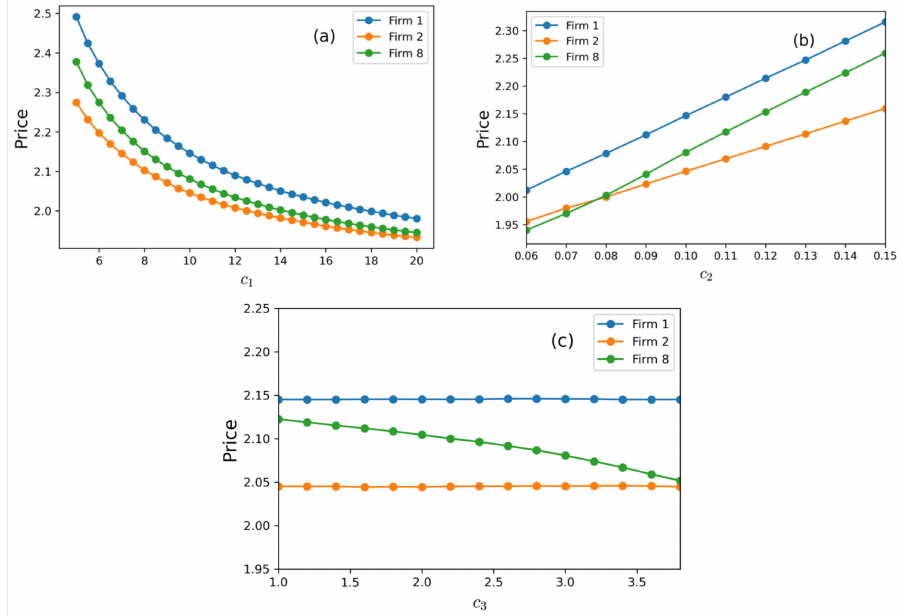
Figure 7. Sensitivity analysis of parameters ( a ) c 1 , ( b ) c 2 and ( c ) c 3 defined in the utility function.